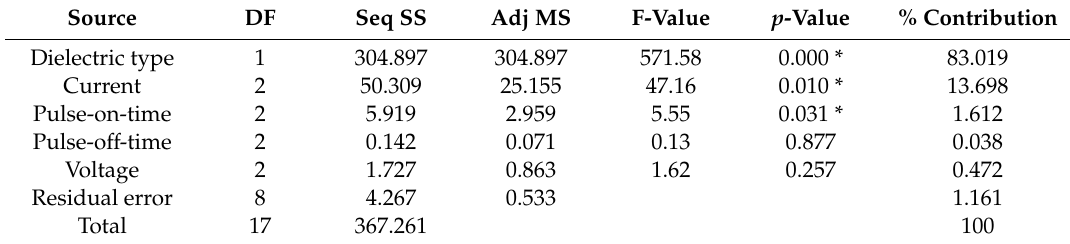
Table 6. Analysis of variance for signal-to-noise ratios of Microhardness.